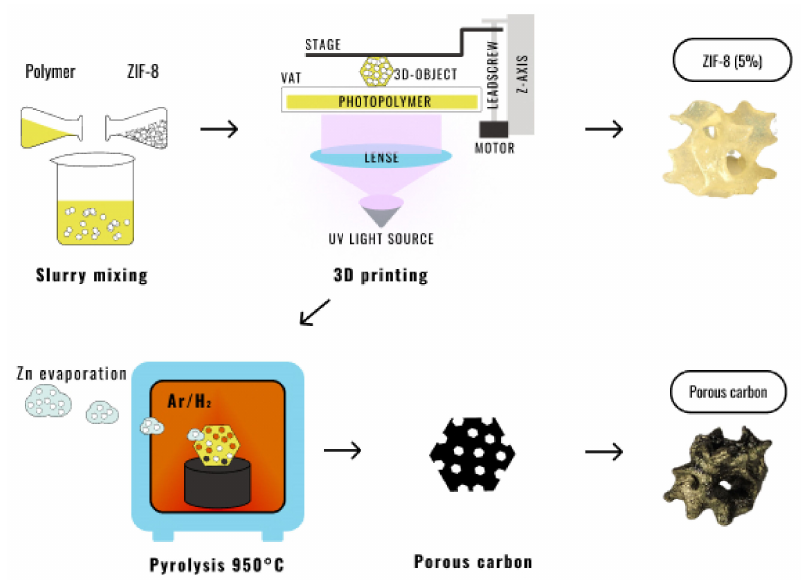
Scheme 1. The proposed approach to 3D-printed porous carbon objects.